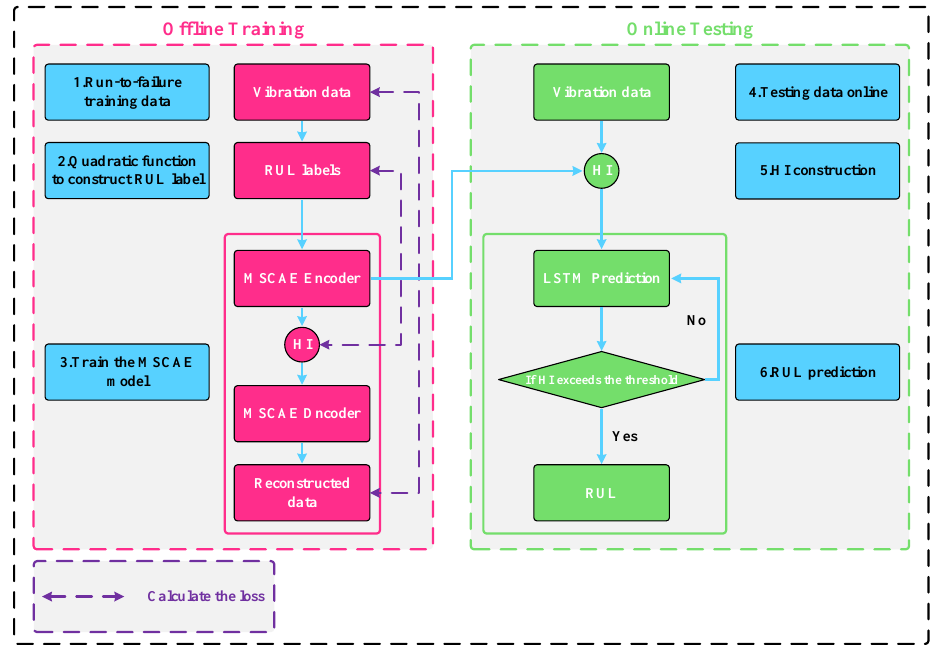
Figure 5. Flow chart of HI extraction and RUL